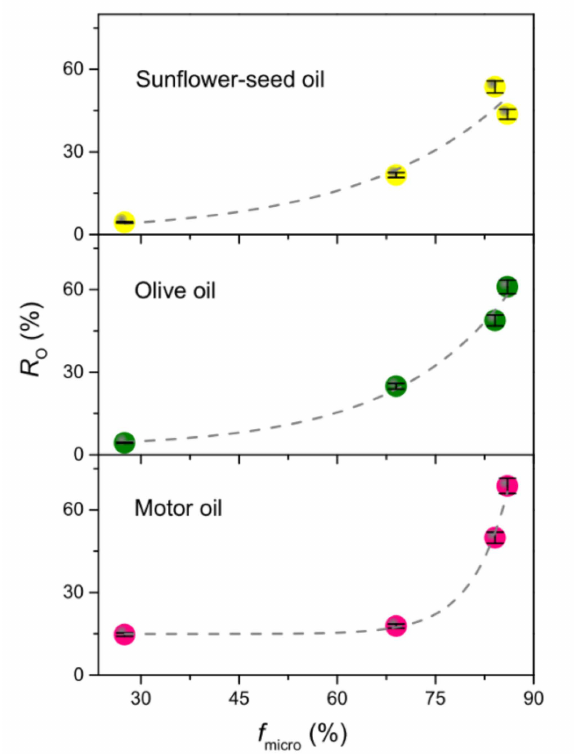
Figure 7. Oil recovery efficiency ( R O ) as a function of the micropore fraction ( f micro